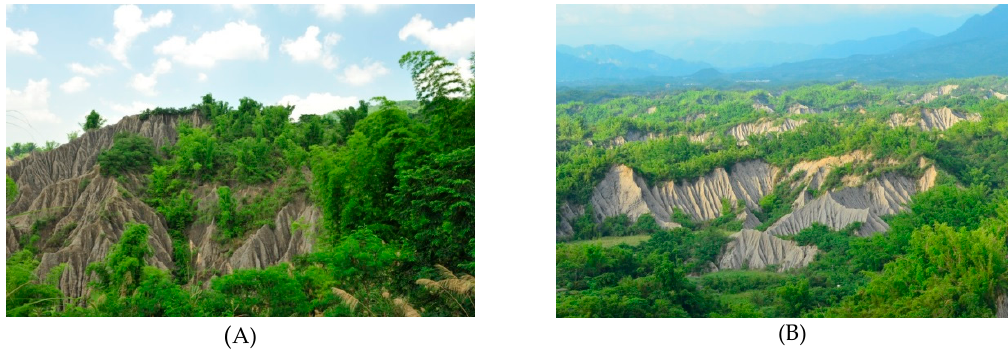
Figure 1. Landscape of the mudstone badland. ( A ) close up view and ( B ) view from a distance at Zuozhen (S1) in Tainan City in southwestern Taiwan. South-facing slopes are barren due to lower soil moisture and more direct sun, and north-facing slopes are covered with thorny bamboo.